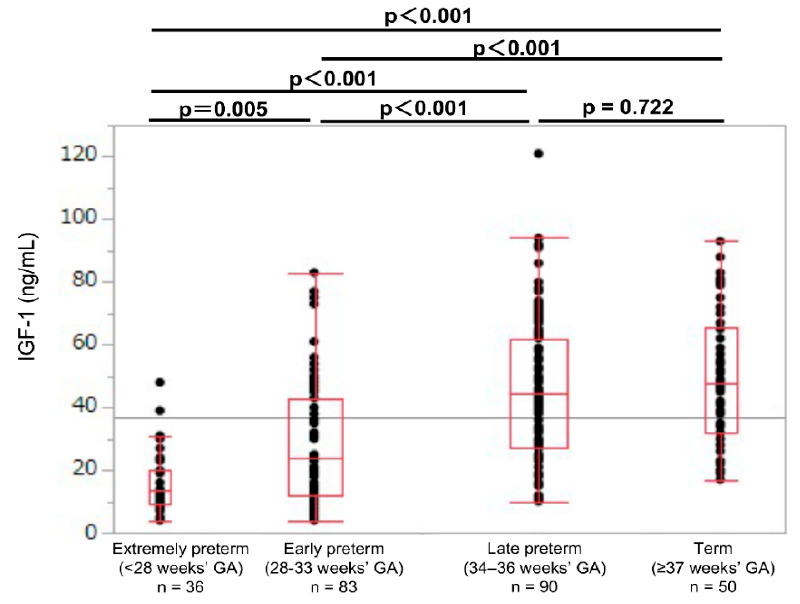
Figure 2. Umbilical cord IGF-1 levels in extremely preterm, early preterm, late preterm, and term